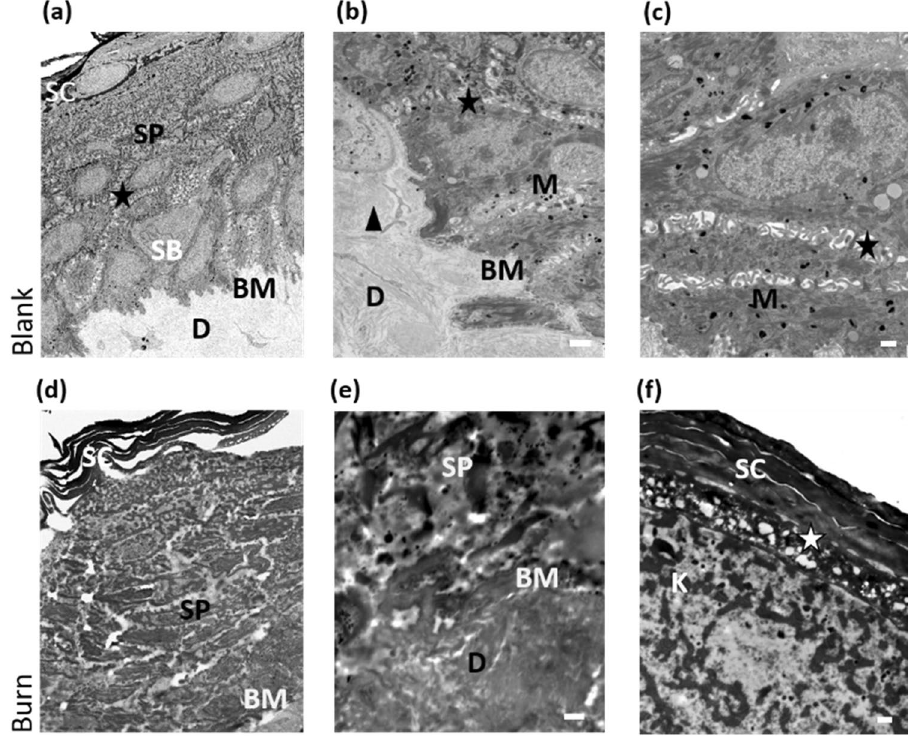
Figure 3. Partial thickness burns disrupt the ultrastructural organization of epidermis and dermis. ( a ) Overview of blank, untreated skin including 25 stitched micrographs (magnification ×1700); SC ( stratum corneum ), SP ( stratum spinosum ) with keratinocytes—( a ), ( b ), ( c ) asterisks indicate connections of keratinocytes, SB ( stratum basale ) with BM (basement membrane). ( b ), ( c ) detailed TEM micrographs of epidermal–dermal transitions. Areas are rich in M (melanocytes) associated with keratinocytes and are located in the lowest epidermal layer. ( b ) Dermis—arrowhead indicates collagen fibres in various directions. ( d ) Overview of a burnt skin including 25 stitched micrographs (magnification 1700x) showing SC and SP. ( e ), ( f ) detailed TEM micrographs of epidermis of burnt skin. ( e ) BM between SP and dermis is hardly detectable; the borders of all cellular structures are missing. ( f ) Stratum granulosum (white asterisk) illustrates blowy inclusions and loose structures. Scale bars: ( b ) 500 nm, ( c ) 1000 nm, ( e ) 500 nm and ( f ) 1000